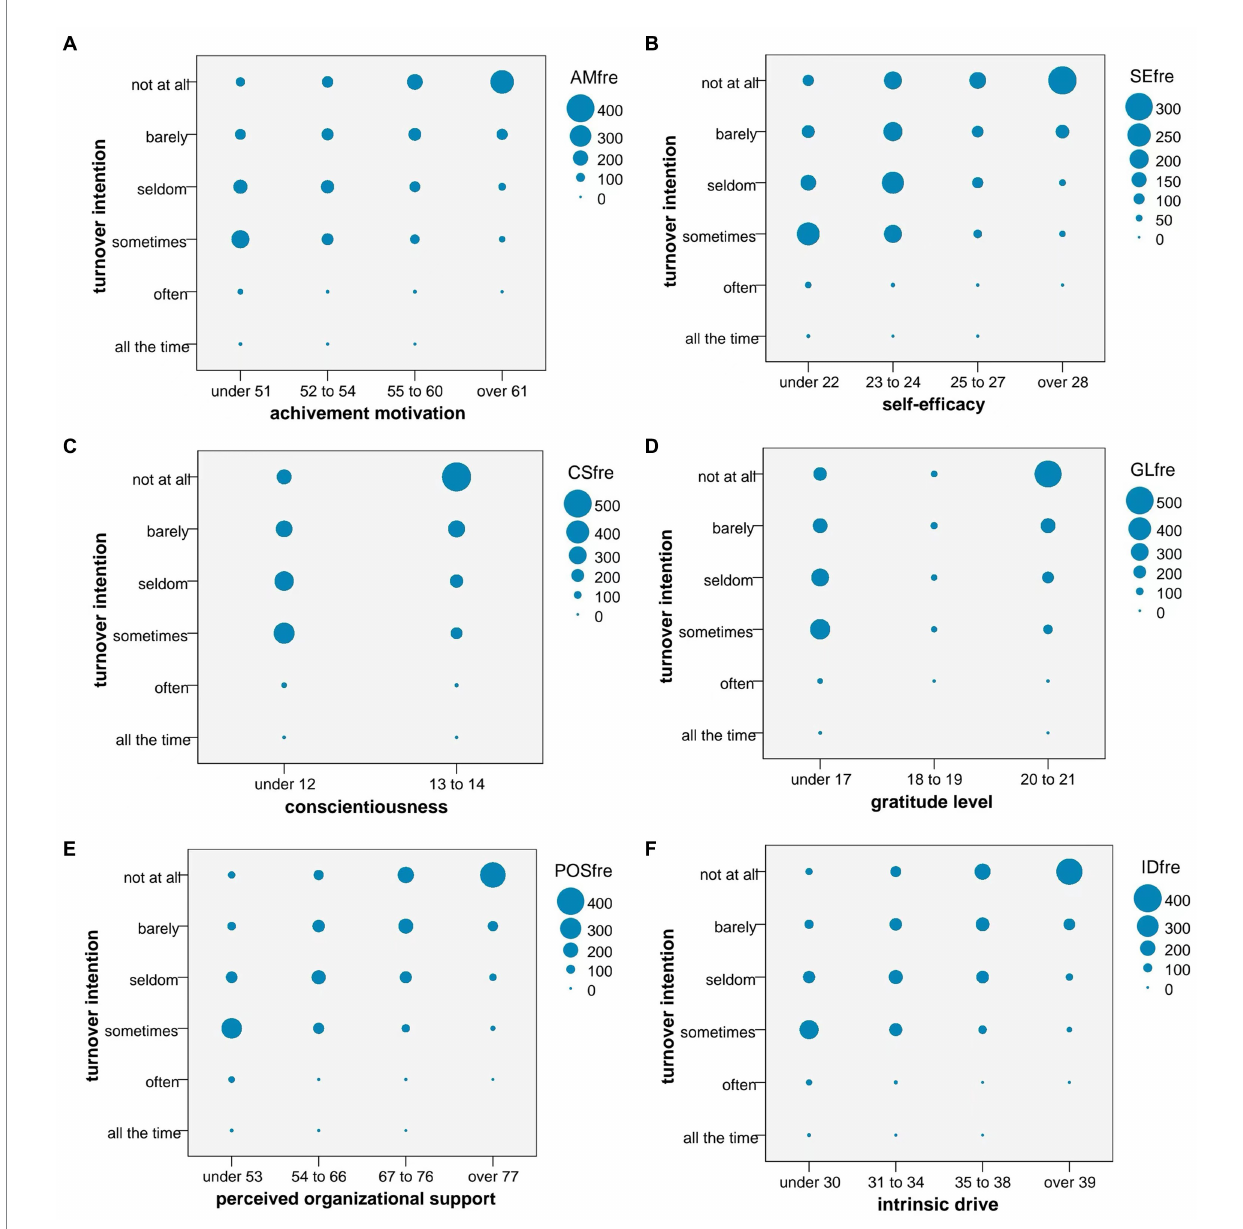
FIGURE 2 (A) The number of people with varying levels of turnover intention in achievement motivation. AMfre = Frequency of different turnover intentions at different achievement motivation levels. (B) The number of people with varying levels of turnover intention in self-efficacy. SEfre = Frequency of different turnover intentions at different self-efficacy levels. (C) The number of people with varying levels of turnover intention in conscientiousness. CSfre = Frequency of different turnover intentions at different conscientiousness levels. Because the scores for conscientiousness differed little, they were divided into two groups. (D) The number of people with varying levels of turnover intention in gratitude level. GLfre = Frequency of different turnover intentions at different gratitude level levels. Because the scores for gratitude level differed little, they were divided into three groups. (E) The number of people with varying levels of turnover intention in perceived organizational support. POSfre = Frequency of different turnover intentions at different perceived organizational support levels. (F) The number of people with varying levels of turnover intention in intrinsic drive. IDfre = Frequency of different turnover intentions at different intrinsic drive